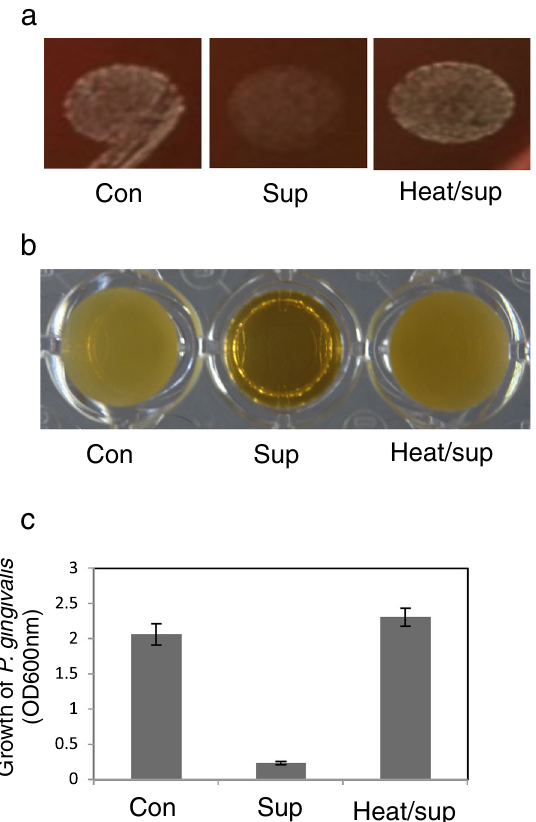
Figure 5. The cell culture supernatant of G. haemolysans exhibits the growth suppression ability against P. gingivalis . (a) P. gingivalis was cultured on blood agar containing sterile GAM medium (as a control, left panel), culture supernatant of G. haemolysans (middle panel), or heat-treated culture supernatant of G. haemolysans (right panel). (b) P. gingivalis was cultured in liquid medium containing PBS (as a control, left), culture supernatant of G. haemolysans (center), or heat-treated culture supernatant of G. haemolysans (right). (c) Quantification of the growth of P. gingivalis observed in (b) . The optical density was measured at 600 nm to determine the concentration of P. gingivalis . Error bars show the mean ± SD. All results are representative of data generated in at least three independent